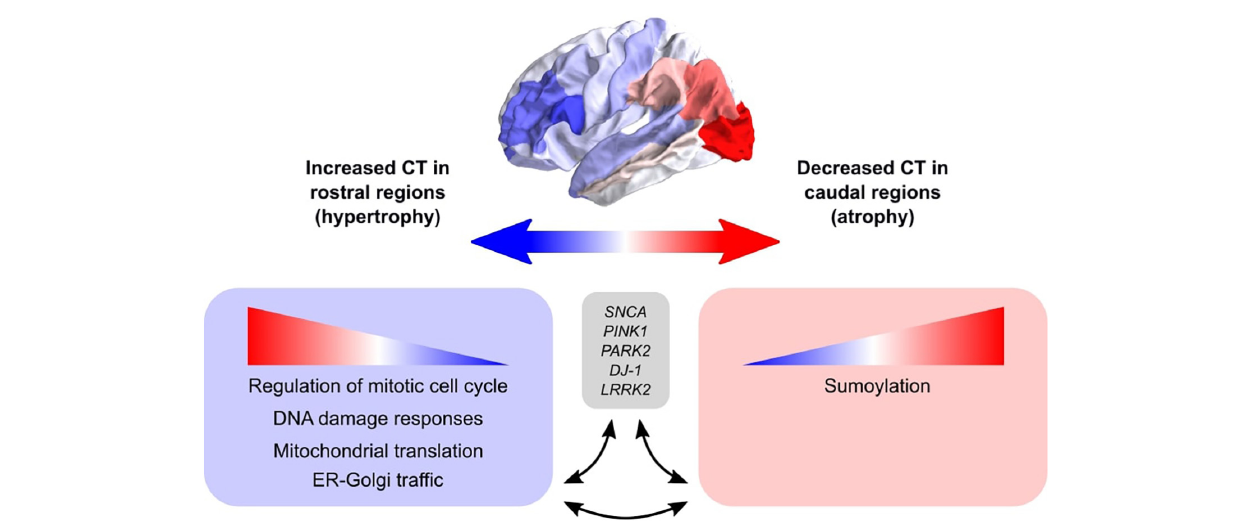
FIGURE 8 | Schematic overview of the balance between biological pathways and their influence on CT across cortical brain regions. The big arrow indicates the caudal-to-rostral (red-to-blue) or rostral-to-caudal (blue-to-red) change in CT across cortical brain regions of PD patients with red indicating decreased CT (atrophy) in caudal regions and blue indicating increased CT (hypertrophy) in rostral regions. Genes within pathways associated with sumoylation showed that the expression of these genes within the pathways increases from rostral to caudal regions. Other biological pathways that were correlated with CT changes in PD included regulation of mitotic cell cycle, mitochondrial translation, DNA damage responses, and ER-Golgi traffic, and the involved genes showed decreasing expression patterns from rostral to caudal regions (or increasing from caudal to rostral regions). All enriched pathways shared many common genes and were generally associated with cellular maintenance mechanisms. Literature studies suggest that these biological pathways may be involved in the pathobiology of PD through their interaction with genetic risk variants.